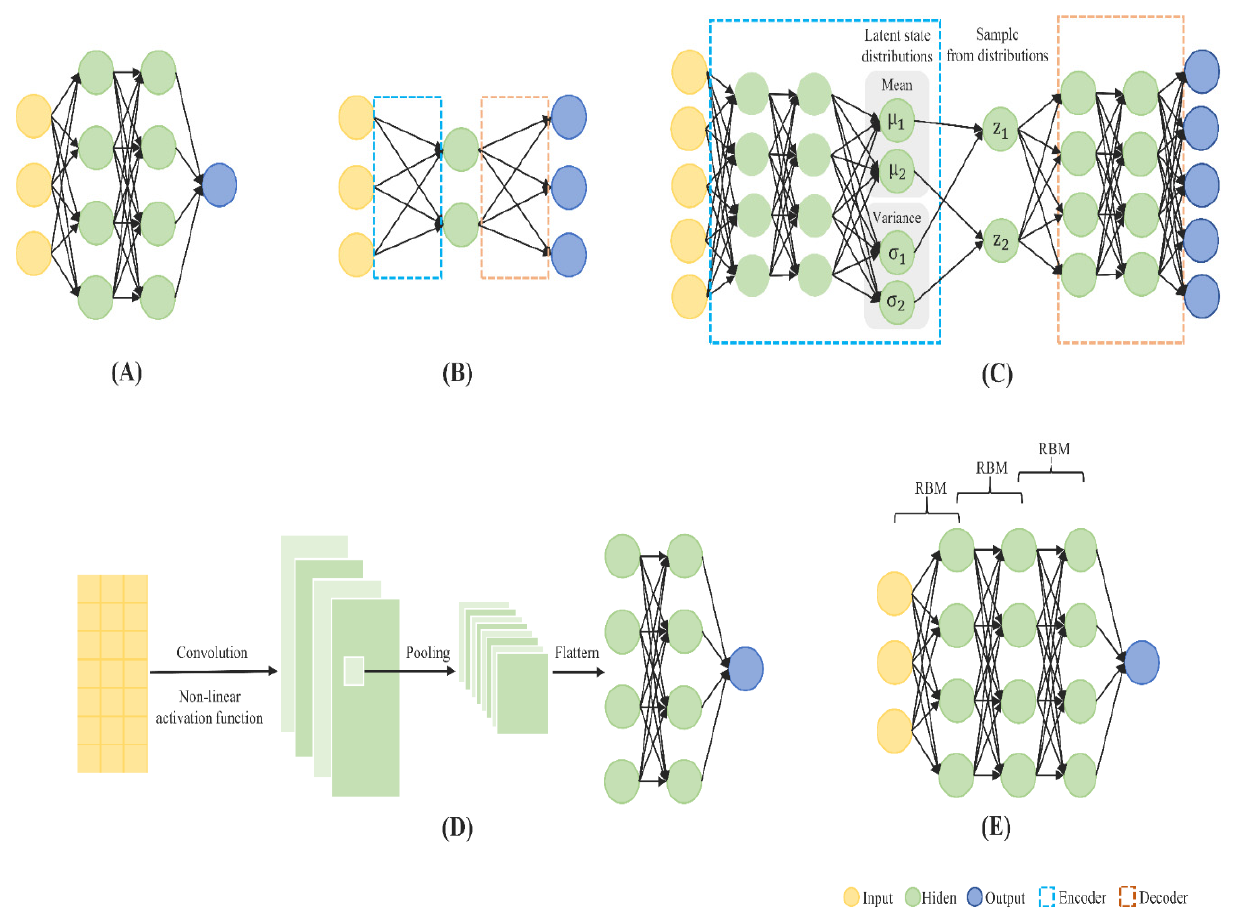
Figure 4. DL architectures that have been applied in epigenomics to solve some human diseases-related prediction tasks. ( A ) Multi-layer perceptron, ( B ) Autoencoder, ( C ) Variational autoencoder, ( D ) Convolutional neural network, ( E ) Deep belief network.